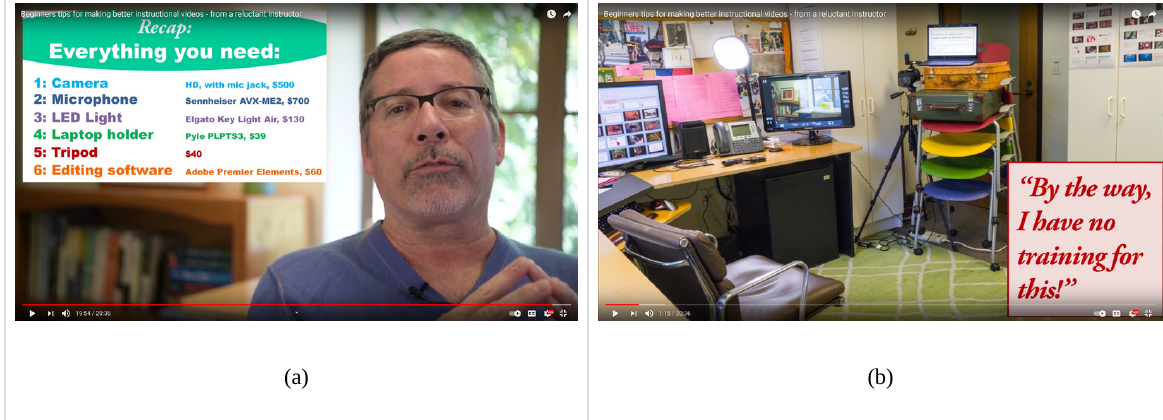
Figure 12. Screenshots of YouTube instructional video for producing asynchronous lectures by UCLA Prof. Jay Phelan, an evolutionary biologist and award-winning teacher. (a) main scene of Prof. Phelan’s online lecture, with a list of his components; and (b) his setup for recording lectures. Source: Jay Phelan’s YouTube video, https://www.youtube.com/watch?v=znzECF9V- h4&t=835s (accessed 6 March